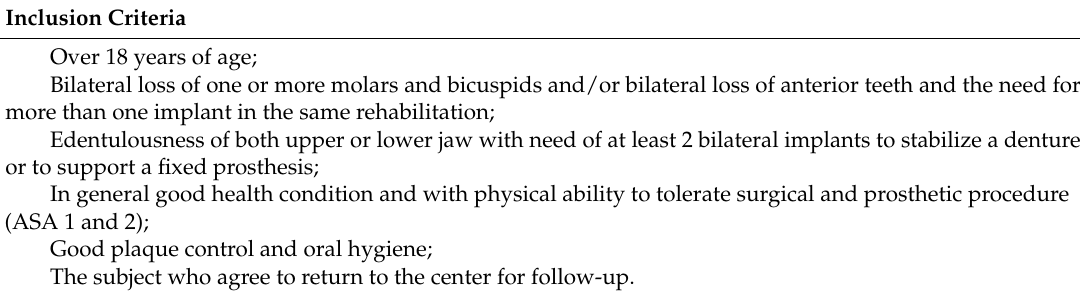
Table 5. Criteria for inclusion in the clinical